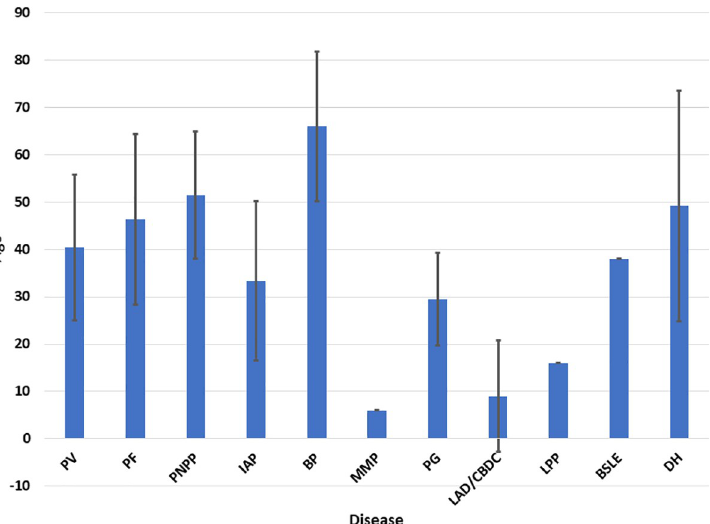
Fig 4. Bar chart for the mean age at presentation and standard deviation for each autoimmune bullous disease. BP, bullous pemphigoid; BSLE, bullous systemic lupus erythematosus; DH, dermatitis herpetiformis; IAP, immunoglobulin A pemphigus; LAD/CBDC, linear immunoglobulin A disease/chronic bullous disease of the childhood; LPP, lichen planus pemphigoides; MMP, mucous membrane pemphigoid; PF, pemphigus foliaceous; PG, pemphigoid gestationis; PNPP, paraneoplastic pemphigus; PV, pemphigus vulgaris.